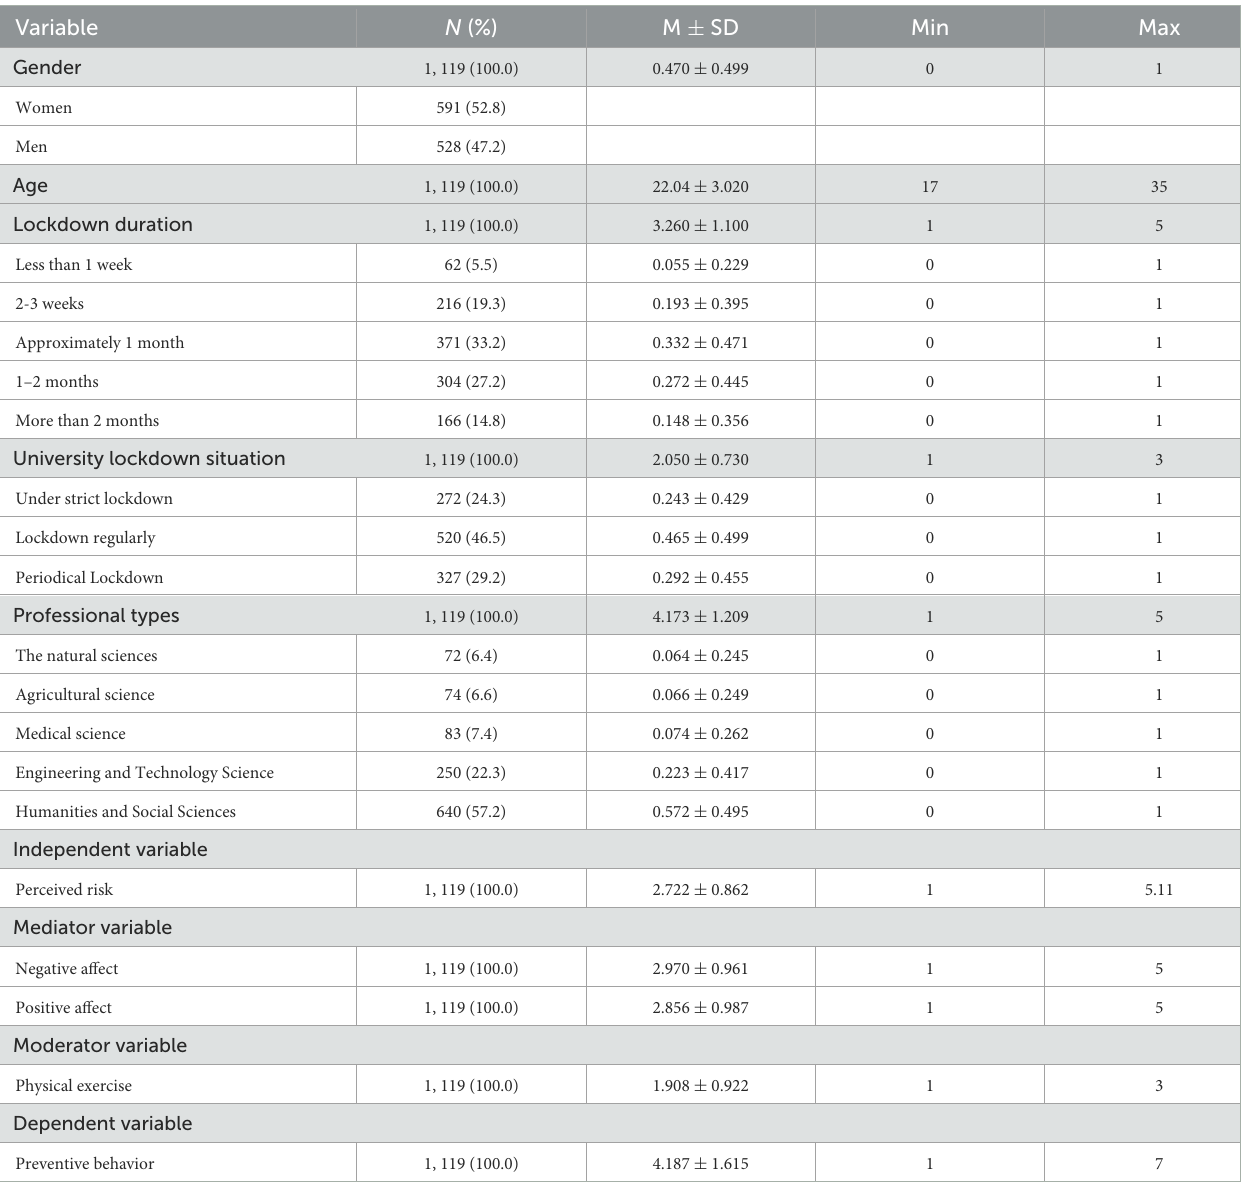
TABLE 1 Sample descriptive statistics information ( N = 1,